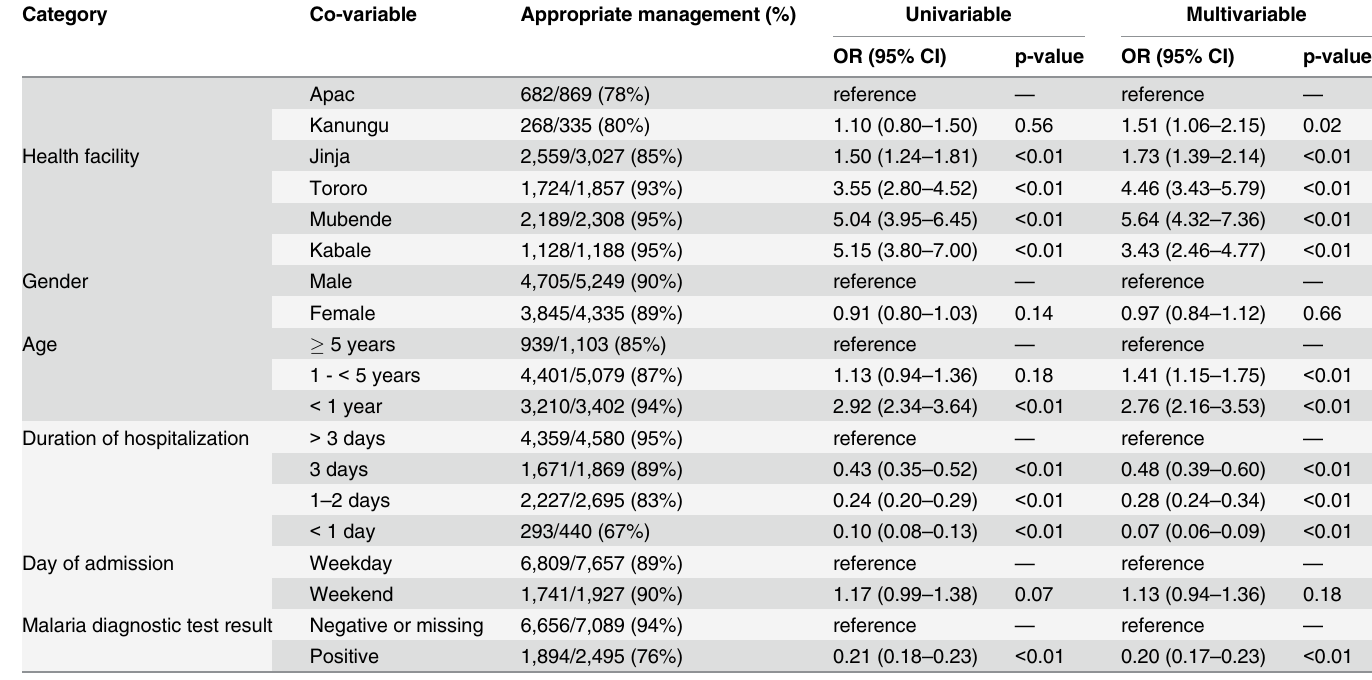
Table 5. Associations between characteristics and appropriate inpatient antibiotic prescription for selected illnesses a . Category